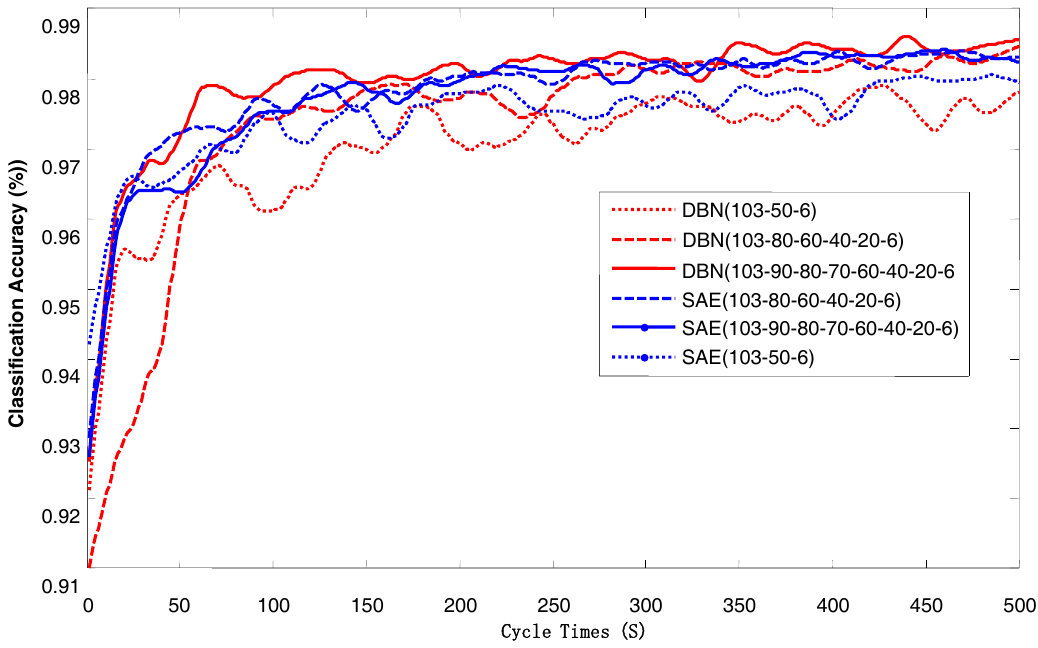
Figure 12. The classification accuracy of different network depths varies with training cycles.